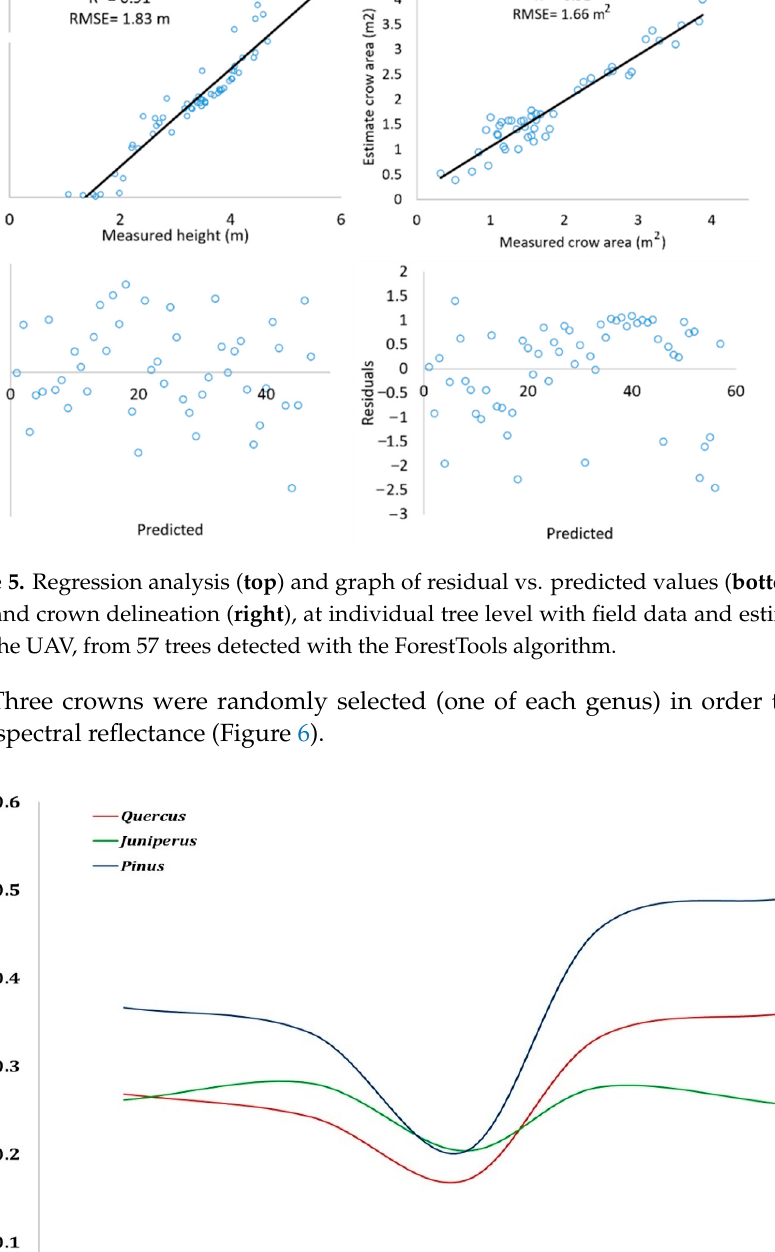
Figure 4. Digitalization of trees ( top left ), digitalization of crowns ( top right ), trees identified ( bot- tom left ) and crowns detected ( bottom right ) using the ForestTools algorithm.